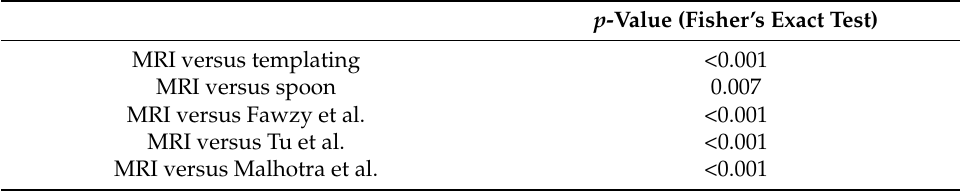
Table 2. Statistical analysis comparing different